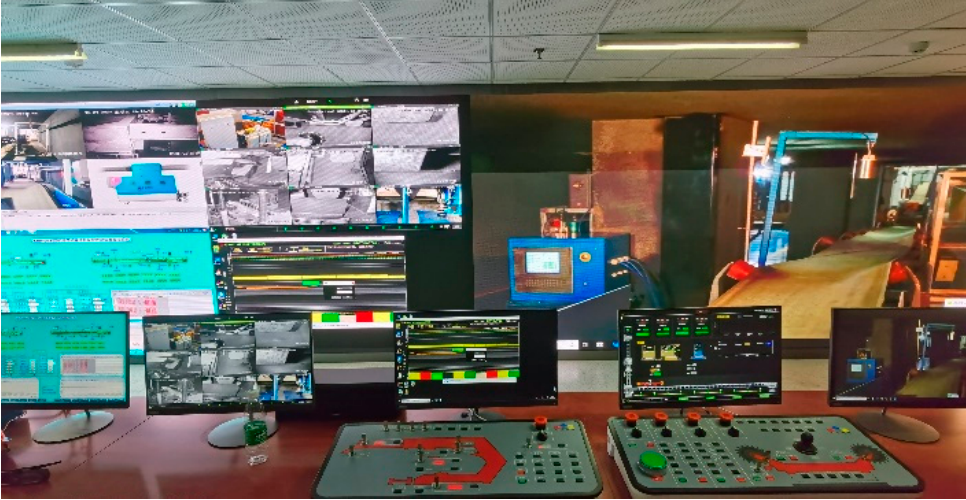
Figure 7. Schematic diagram of intelligent video surveillance technology.